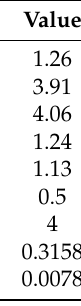
Table 1. Motor Table 1. Motor parameter.